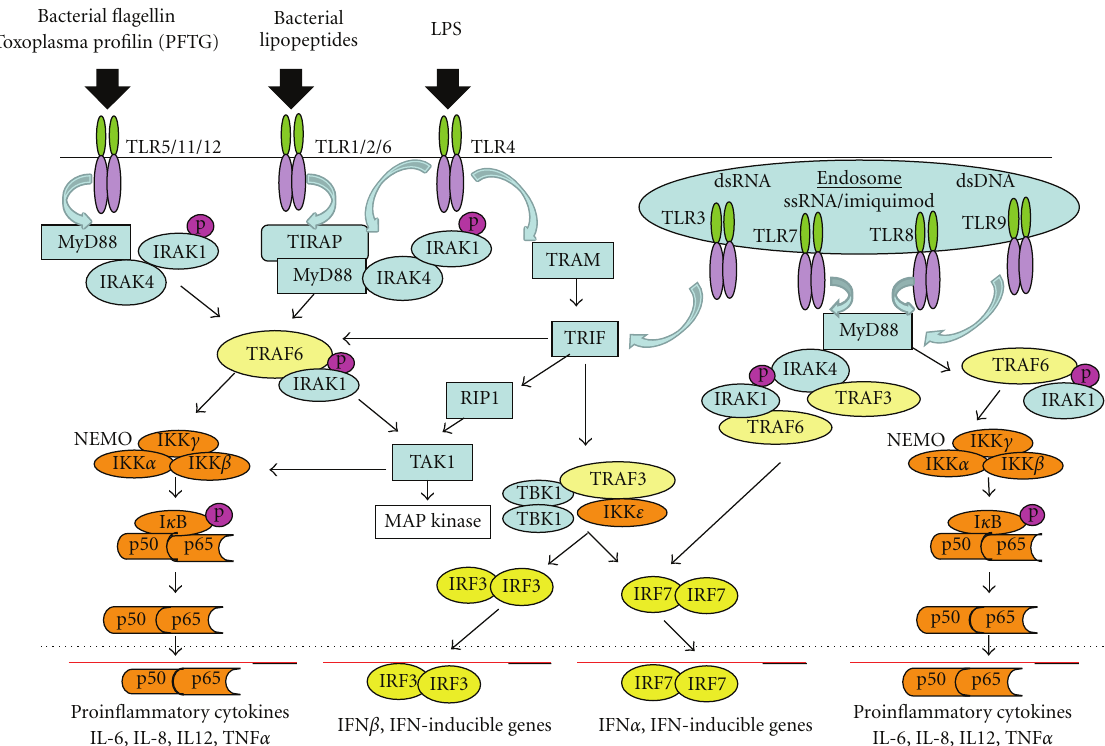
Figure 1: The TLR signaling pathway and downstream e ff ector molecules. Depicted are key TLR molecules, their signaling adaptors and downstream mediators that are essential for TLR signaling and function. The specific molecules in this network that are presently being interrogated as potential therapeutic targets include TLR7/9, MyD88 and IRAK1/4, as discussed in the